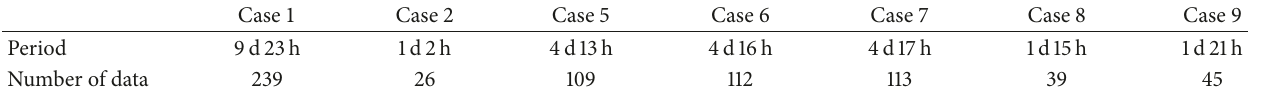
Figure 2: Observed trajectories of the seven drifters used to build our predictive models. Table 1: Period and number of datasets measured.